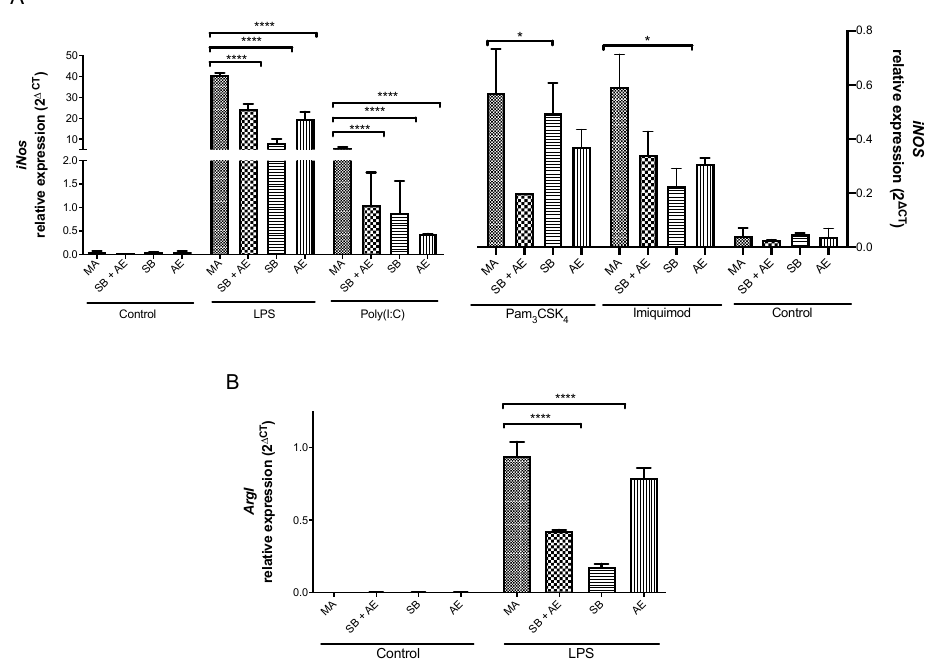
Figure 6. Relative gene expression of iNos ( A ) and ArgI ( B ) mRNAs by qRT-PCR in RAW 264.7 cells cultured over Ti-discs with different surfaces: mechanical abrasion (MA), sandblasting plus etching (SB + AE), sandblasting (SB) and acid etching (AE) and with or without the TLR ligands LPS (TLR4), Imiquimod (TLR7), Poly(I:C) (TLR3) and Pam3Csk4 (TLR2/1). * p < 0.00332; **** p < 0.0001.